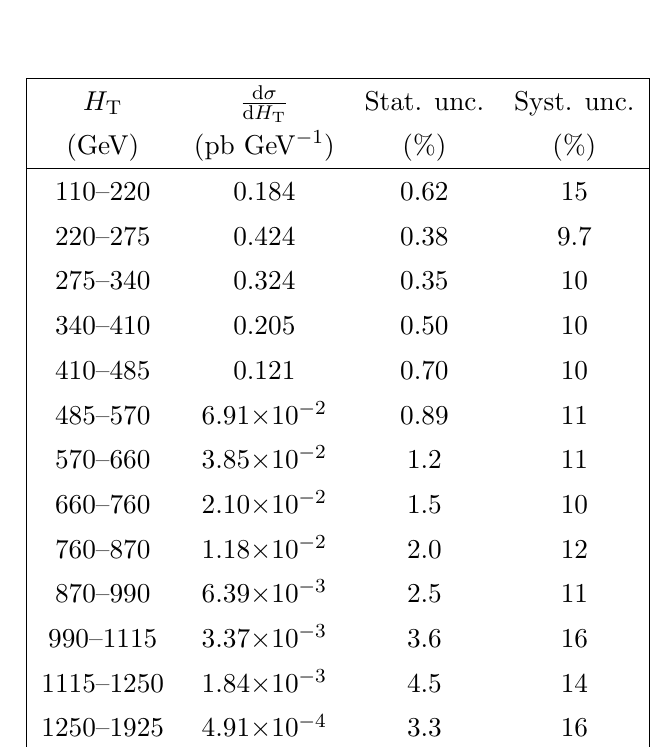
Table 12 . Results of the absolute di(cid:11)erential cross sections with relative uncertainties in the combined channel with respect to H T